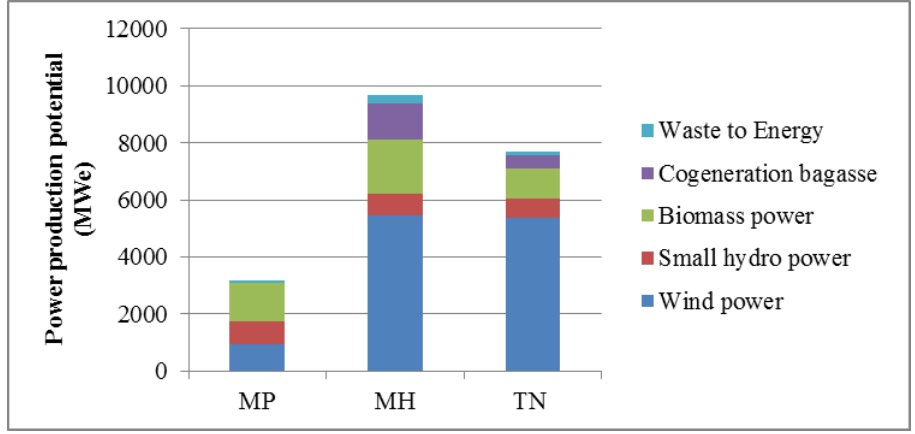
Figure 1. Source-wise renewable power production potential in the three states